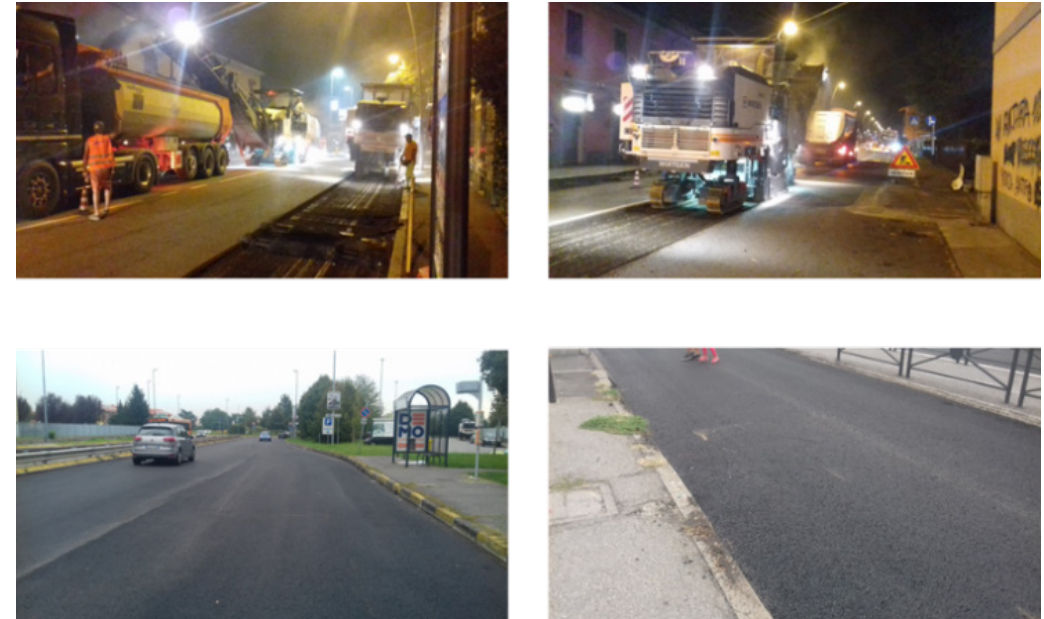
Figure 3: Works for the laying of new low-noise road surface in Viale Libertà (September